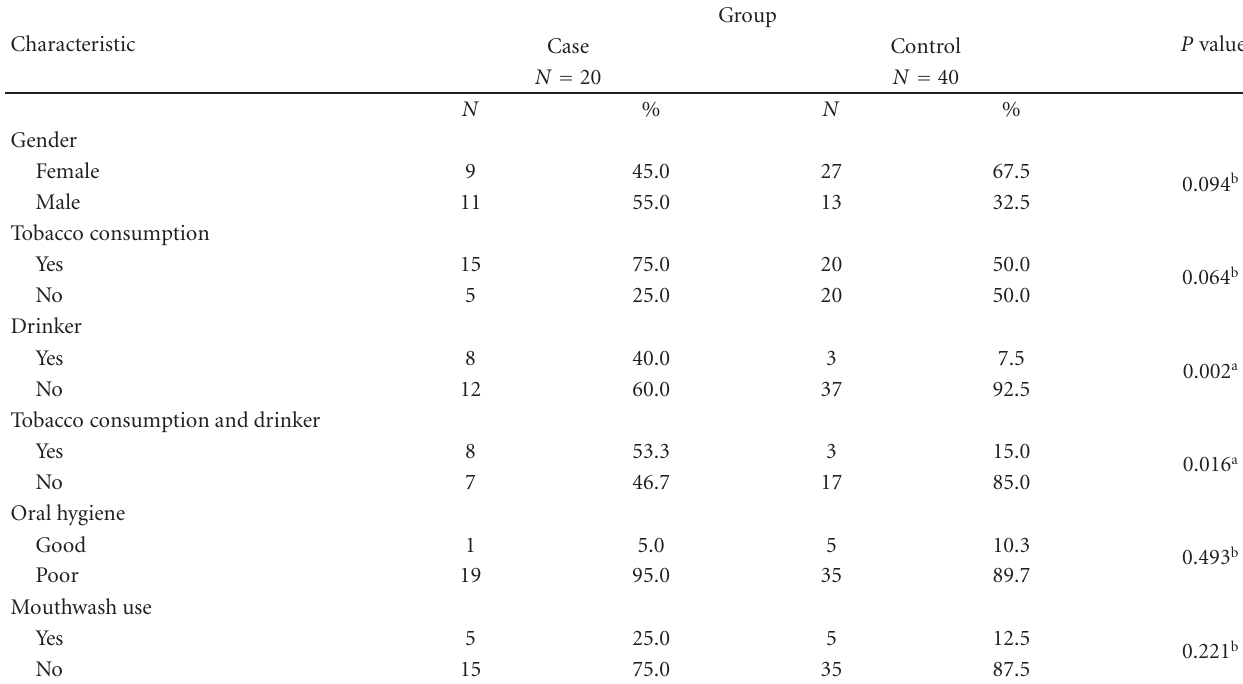
Table 1: Sample characteristics.